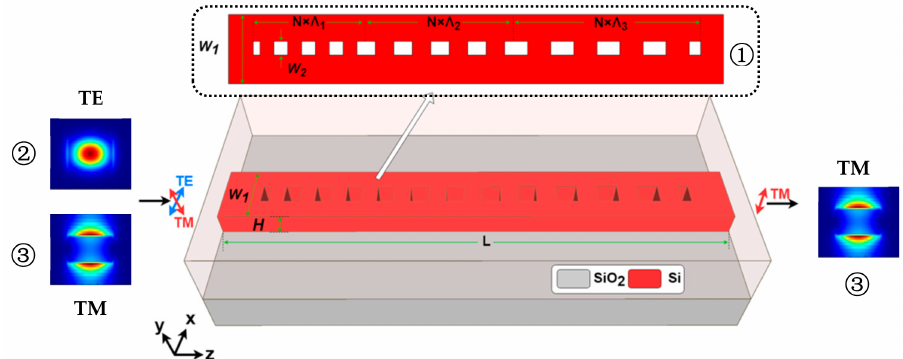
Figure 1. Schematic diagram of the proposed polarizer. Inset 1 (cid:13) : Top view of the proposed TM—pass polarizer; 2 (cid:13) : Mode profile of TE polarization state; 3 (cid:13) : Mode profile of TM polarization